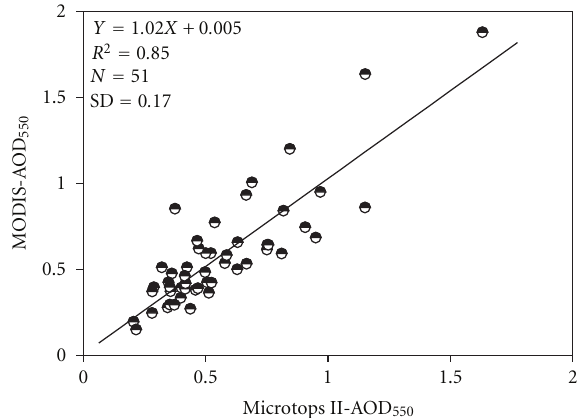
Figure 4: Correlation of Aqua-MODIS AOD 550 versus Microtops-II AOD 550 at the same hour of the Aqua overpass over Patiala during pre-monsoon season (April–June) of 2010.